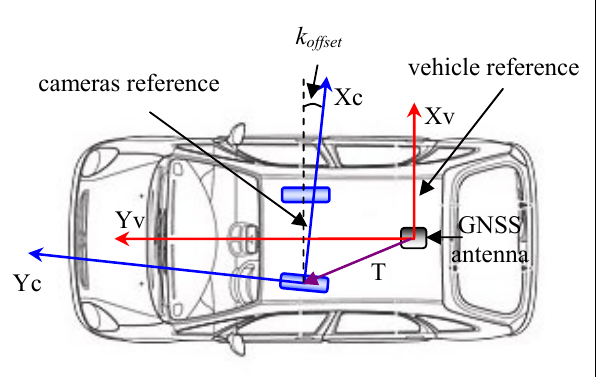
Figure 6. Cameras and vehicle reference